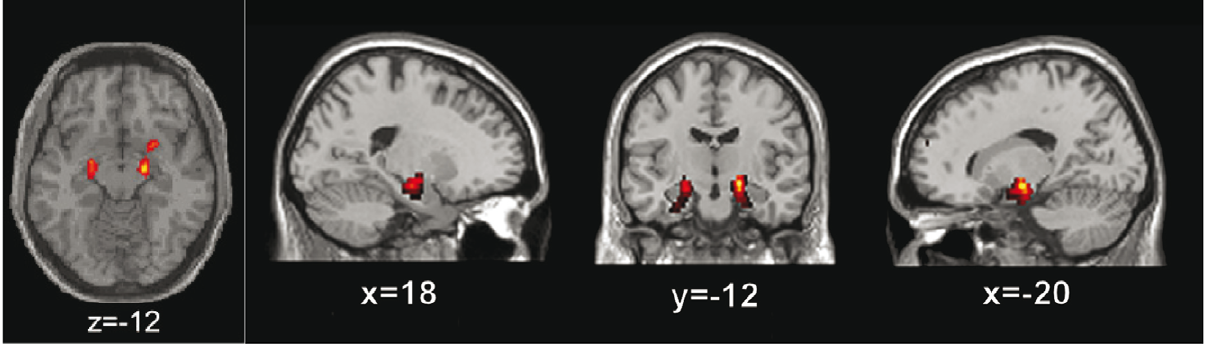
Figure 1. Bilateral reductions of (11)C-FMZ binding potential in amygdala regions in the SPS patient with GAD 65 autoantibodies. This figure shows the results of the statistical parametric mapping (SPM) with voxel-based analysis and thus the comparison of GABA-A receptor binding potential in the patient when compared to normal controls. Note that the (11)C-FMZ binding potential is significantly reduced bilaterally in the patient’s amygdala region.